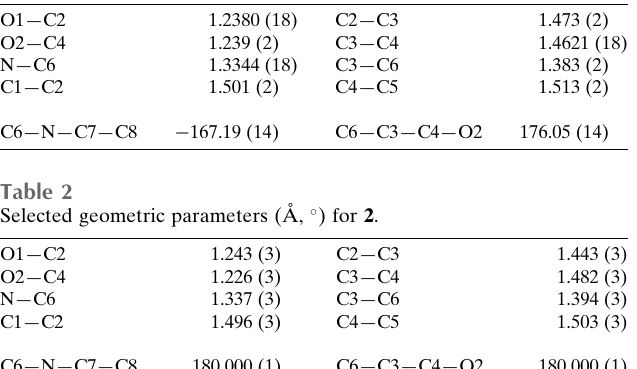
Figure 2 Molecular structure of enamine 2 showing the labelling scheme. The